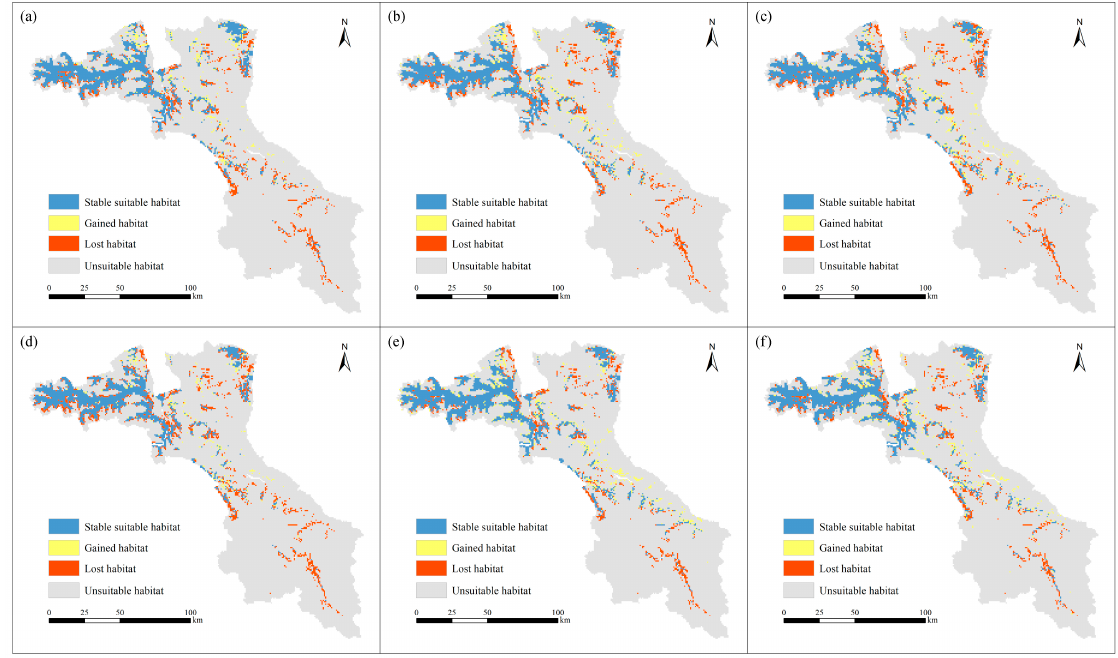
Figure 6. Transfer of suitable habitat for Siberian ibex between current and future climate scenarios in Taxkorgan Nature Reserve. ( a ) RCP 2.6 for 2050; ( b ) RCP 4.5 for 2050; ( c ) RCP 8.5 for 2050; ( d ) RCP 2.6 for 2070; ( e ) RCP 4.5 for 2070; ( f ) RCP 8.5 for 2070.